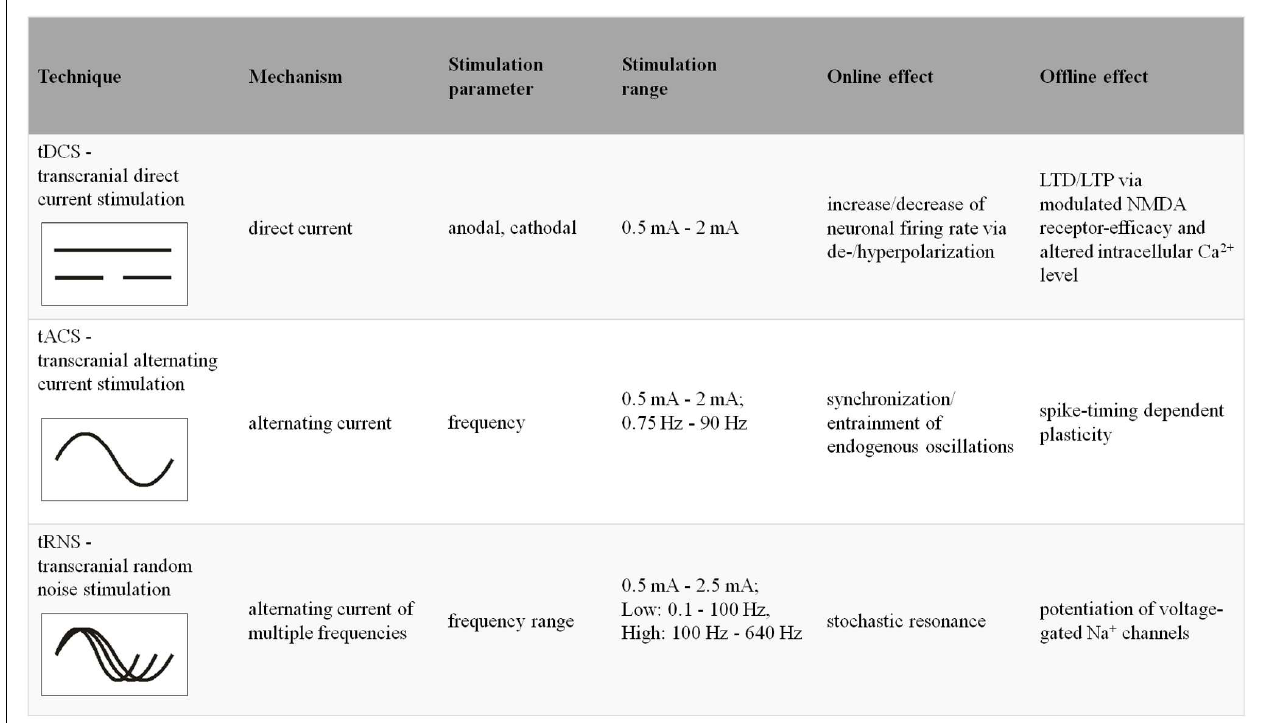
FIGURE 1 | Stimulation parameters and underlying neurophysiological mechanisms of the individual tES-techniques (LTD, long-term depression; LTP, long-term potentiation; NMDA, N -methyl- D -aspartate).